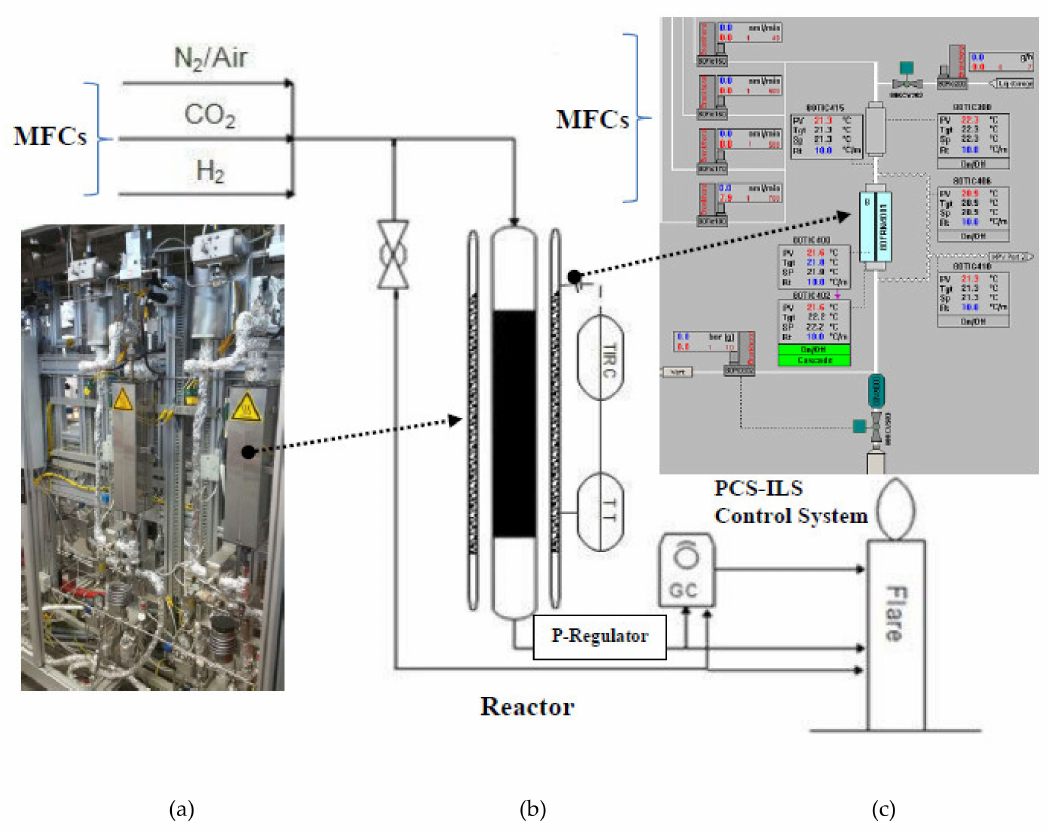
Figure 5. Experimental setup: ( a: left ) picture of the reactor, ( b: middle ) schematic flow diagram, ( c: right-top ) monitor-control